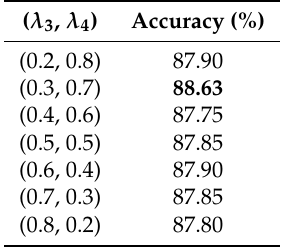
Table 4. The recognition accuracies (%) with different ( λ 3 , λ 4 ) settings.